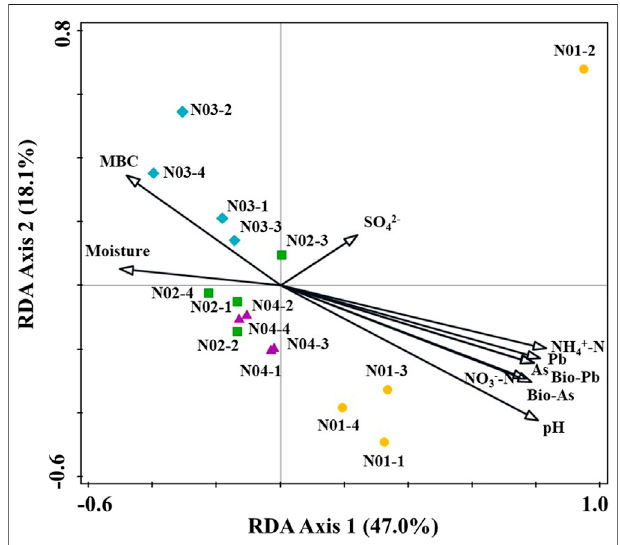
FIGURE 6 | Redundancy analysis (RDA) diagram of the geochemical parameters and the top 35 bacterial genera. Abbreviations: As, Pb, Fe (total As, Pb, Fe in soil); Bio-As, Pb (bioavailability As, Pb); MBC (microbial biomass carbon).